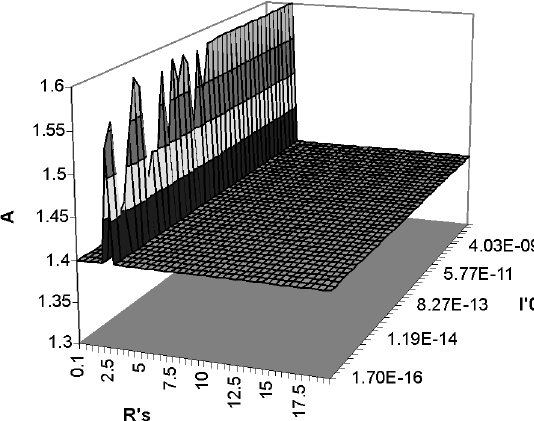
FIGURE 1 Variations of the extracted value of the ideality factor A versus initial values R 0 characteristic ( A ¼ 1.4; R s ¼ 2.5 O ; R sh ¼ 5000 O ; I 0 ¼ 5 (cid:3) 10 (cid:1) 9 A). The computed surface is planar except for ¼ 2 : 5 O R 0 s